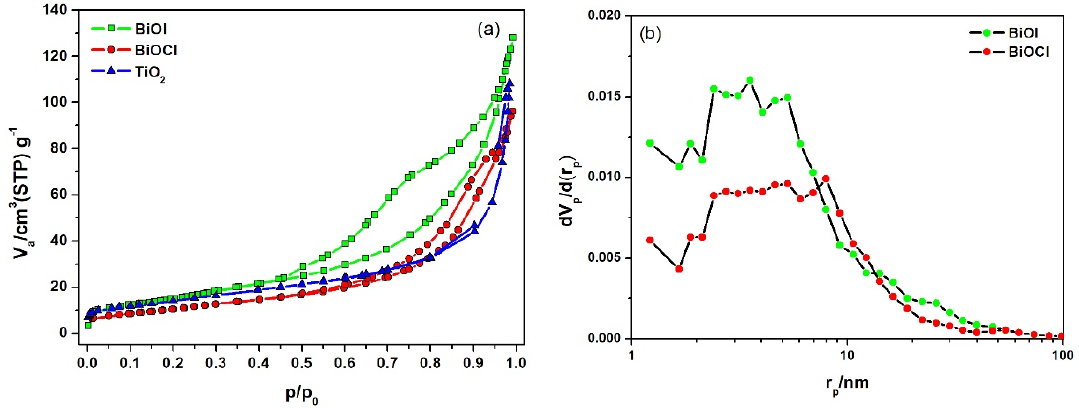
Figure 5. ( a ) N 2 adsorption-desorption isotherms and ( b ) pore-size distribution curves of pure photocatalysts.